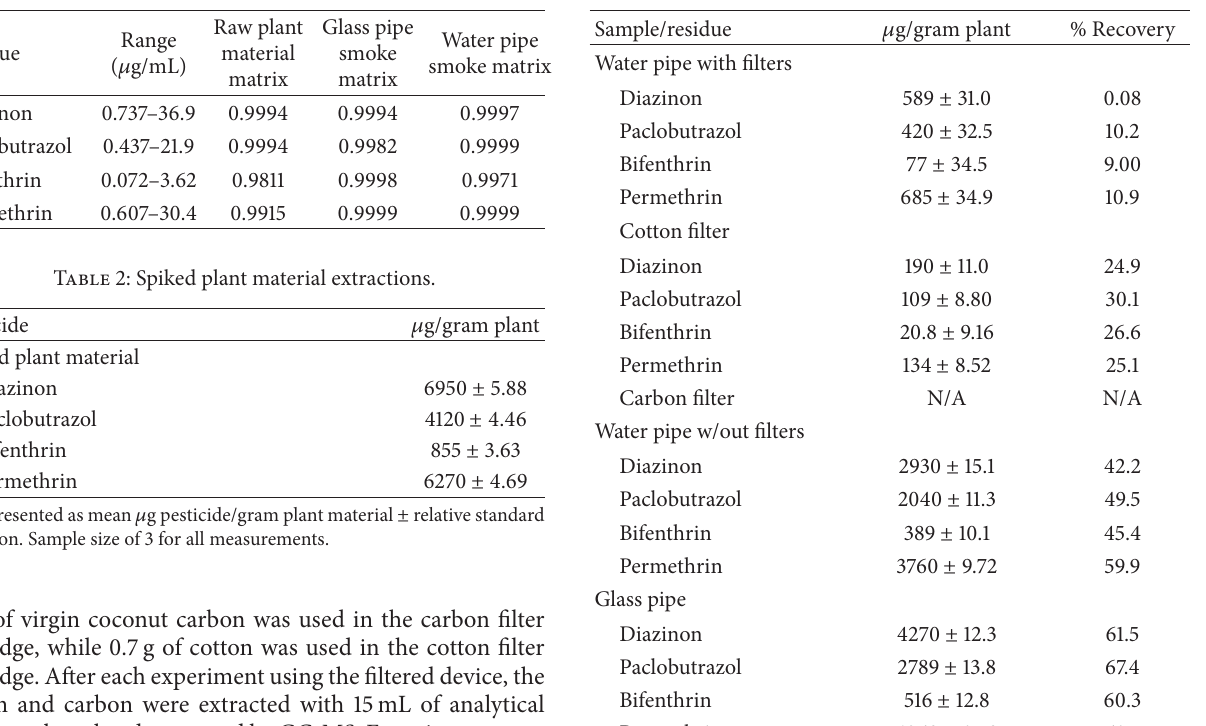
Table 3: Recovery of pesticides in smoke condensate.